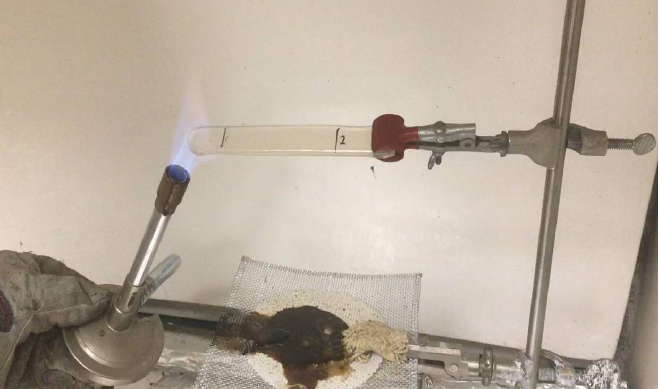
Figure 9. A picture showing the horizontal burn test (following ASTM D635–14 standard).